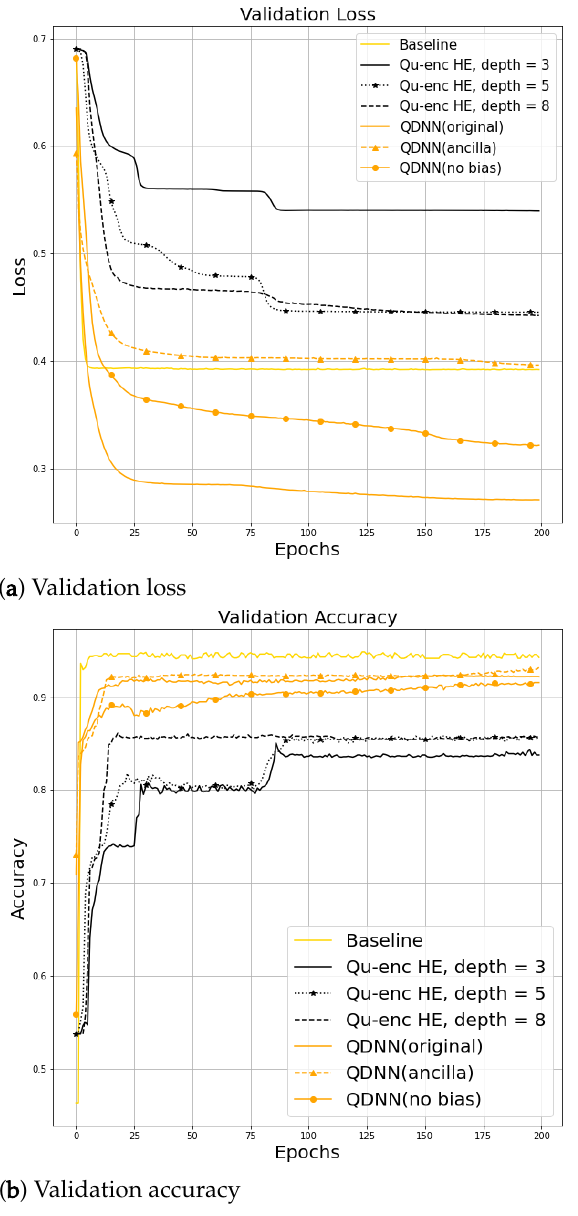
Figure 10. Learning curves in the validation of different QNNs. The average training time (seconds per epoch) of QNNs is shown in Table 2. It can be seen that the training time is strongly dependent on the number of qubits. With 8-qubit HE-encoded QNNs, the training time per epoch is just 10 ∼ 16 s. For the QDNN model and its variants, which also employ 8 qubits, the training time is increased to 25 ∼ 26 s due to the deep architecture. However, when the number of qubits is 16, the training time is significantly increased by approximately 16 ∼ 28 times. Interestingly, given the same number of qubits, the training time is almost linear with respect to the circuit depth, as shown in Figure